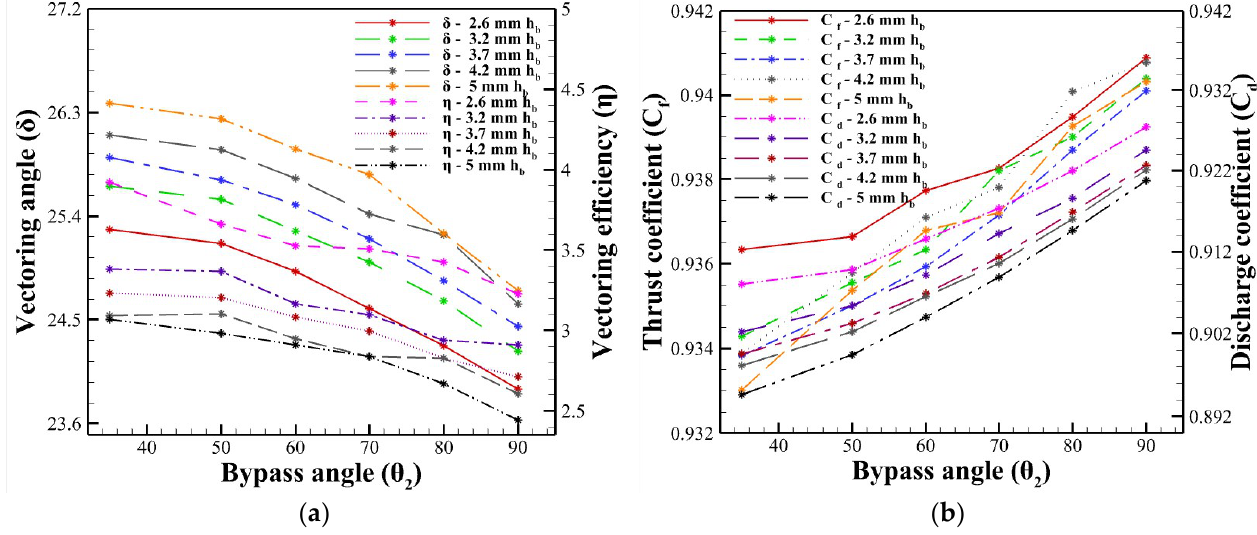
Figure 10. The variation of ( a ) vectoring angle and vectoring efficiency ( b ) thrust coefficient and discharge coefficient with bypass angle.